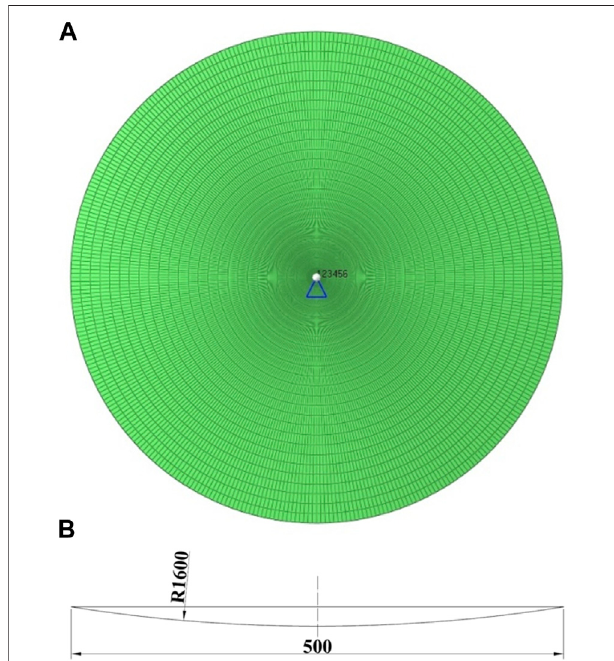
FIGURE 3 | Model of the space mirror. (A) Finite element with the fi xed center point and (B) Front view.